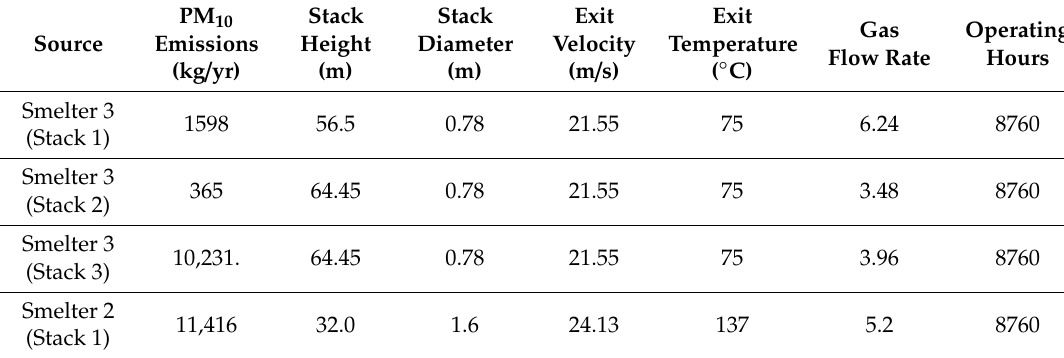
Table 2. 2016 industrial emissions in the